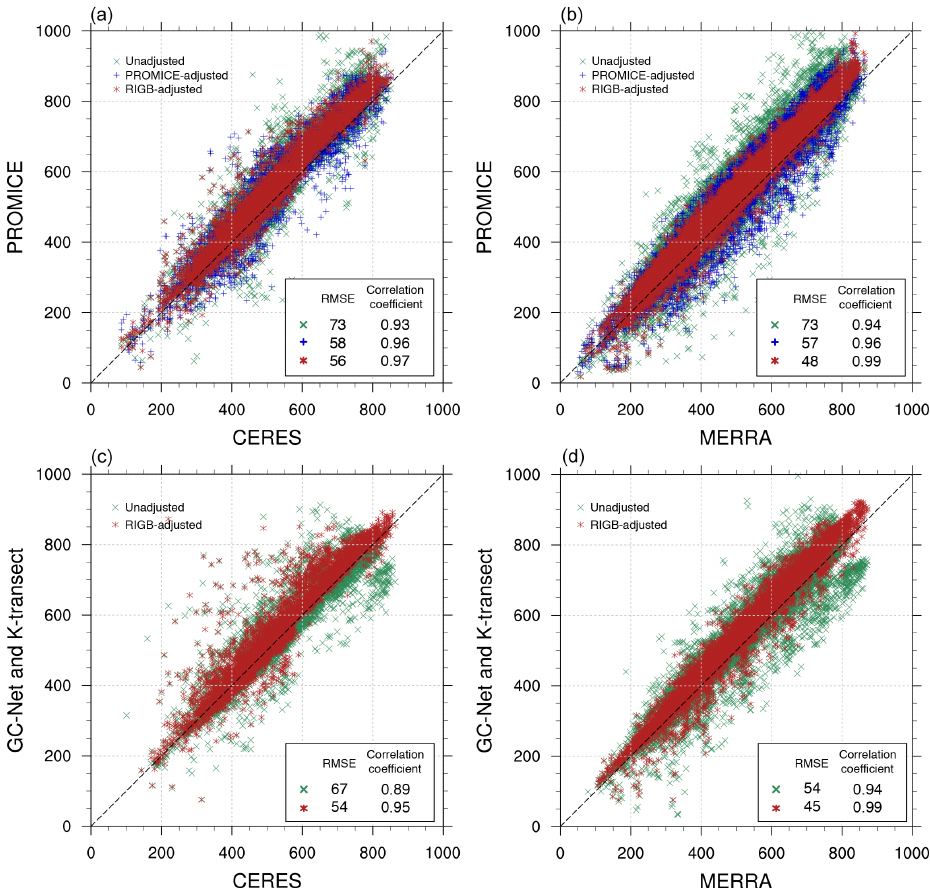
Figure 3. Correlation of insolation (Wm − 2 ) on clear days between (a) PROMICE with CERES; (b) PROMICE with MERRA; (c) GC-Net and K-transect with CERES; (d) GC-Net and K-transect with MERRA.